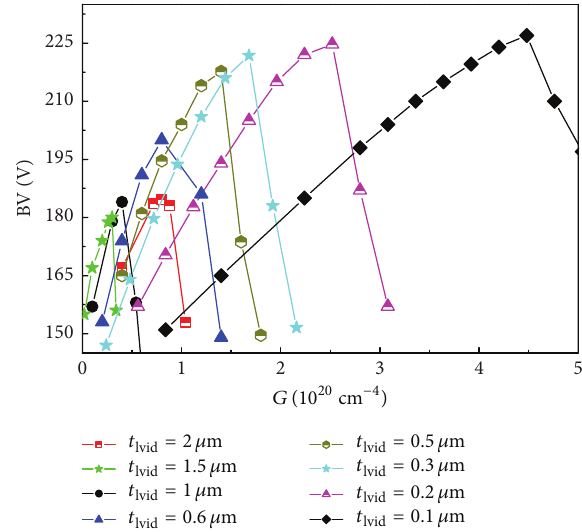
Figure 7: The influence of 𝑡